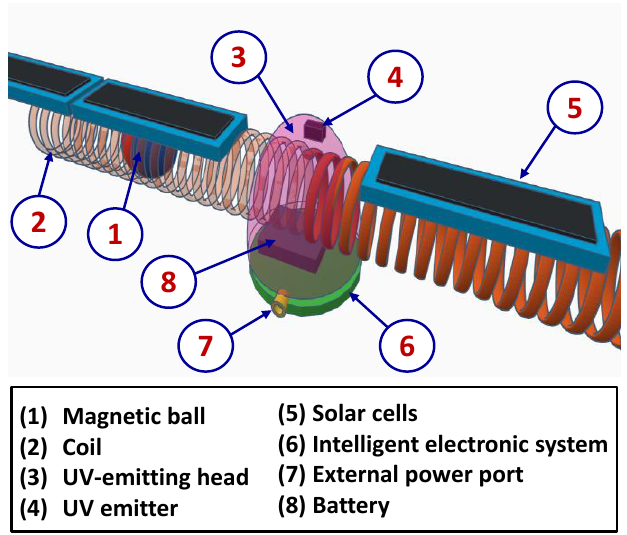
Figure 3. Basis of the power generation system using solar cells and external power supply.